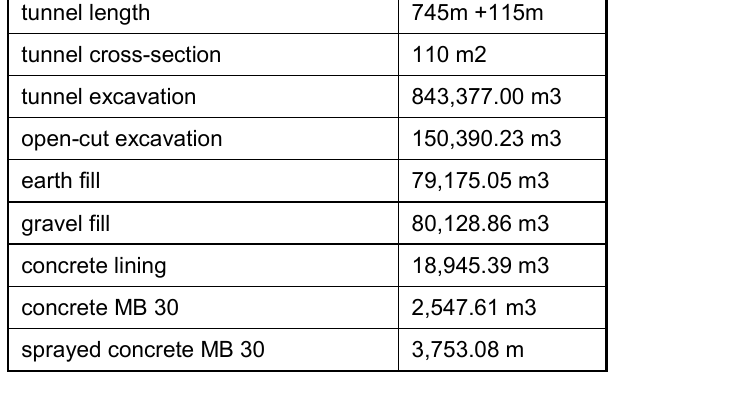
Table 2 – Major data for the Straževica tunnel Таблица 2 – Главные параметры тоннеля Стражевица